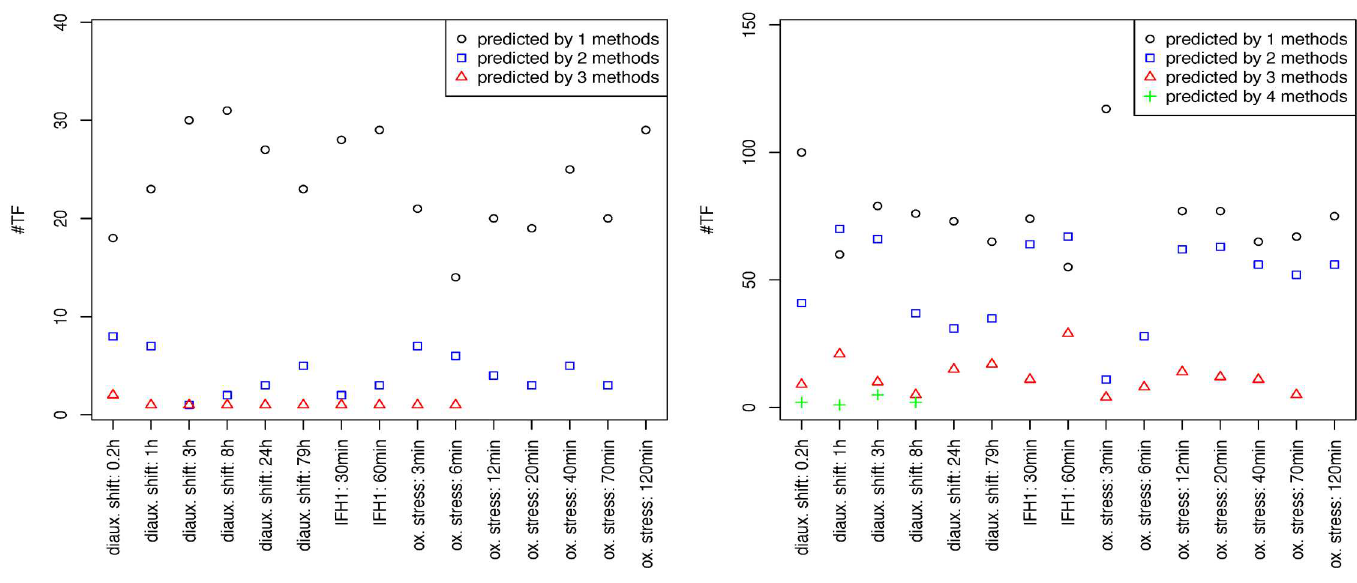
Fig 2. Discrepancy between state-of-the-art methods. For each conditionin the selected datasets the number of TFs that were in the top 10 TFs (left) and all predicted TFs (right) for four different methods (ISMARA, plsgenomics, DREM, T-profiler) are plotted. Most TFs are only predicted by one of the methods. There is no TF that was predicted to be active by all methods if only the top 10 TFs were used and only very few if all predicted TFs are